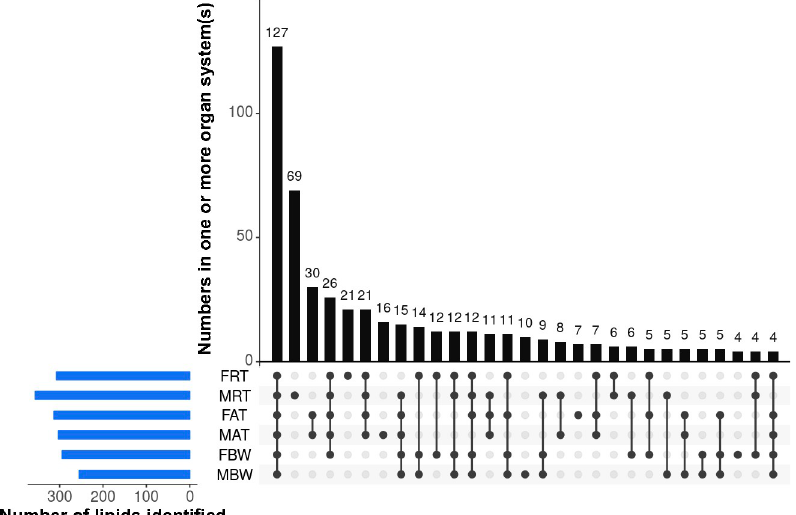
Fig 2. The presence and numbers of lipids identified in six distinct organ systems of Ascaris suum adults (i.e. the reproductive (FRT) and alimentary (FAT) tracts and body wall (FBW) of female adults; the reproductive (MRT) and alimentary (MAT) tracts and body wall (MBW) of male adults). Connected dots display lipid species shared between or among the different organ systems, and the total numbers of lipid species per organ system is shown (bottom